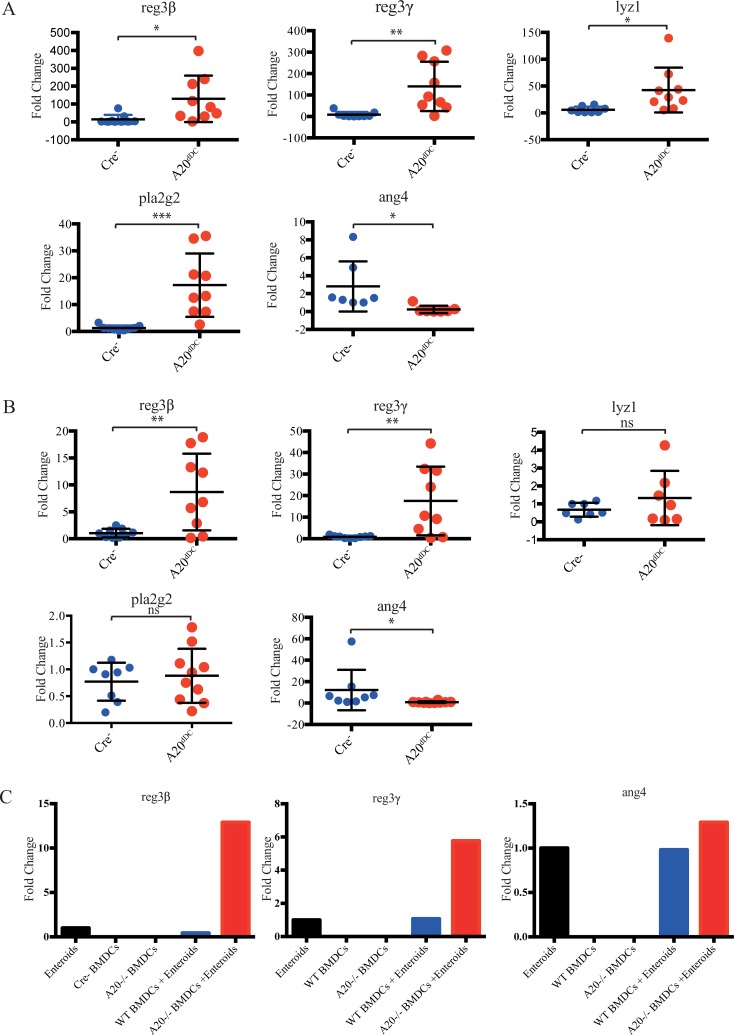
A20 deficient DCs increase transcription of anti-microbial defensins.(A) qPCR analyses of expression of the indicated anti-microbial defensins in proximate colons of A20dDC mice (red, n = 10) and control A20FL/FL (Cre-) mice (blue, n = 8). (B) qPCR analyses of expression of the indicated anti-microbial defensins in ileal tissues of A20dDC mice (n = 9) and control A20FL/FL (Cre-) mice (n = 9). Values are expressed as fold changes normalized to hprt expression, and represent means +/- SEM. * = p<0.05, ** = p<0.01, *** = p<0.001 by T-test. (C) qPCR analyses of expression of the indicated anti-microbial defensins from DC—IEC enteroid co-cultures. Bone marrow derived DCs that were either A20 deficient or A20 competent were co-cultured with WT IEC enteroids for 48 hours, after which co-cultures were harvested for qPCR analyses. Note that A20 deficient DCs cause greater IEC expression of selected defensins. Values are expressed as fold changes normalized to hprt expression, and represent means +/- SEM. * = p<0.05, ** = p<0.01, *** = p<0.001 by T-test. NB: Data are representative of 3 independent experiments.